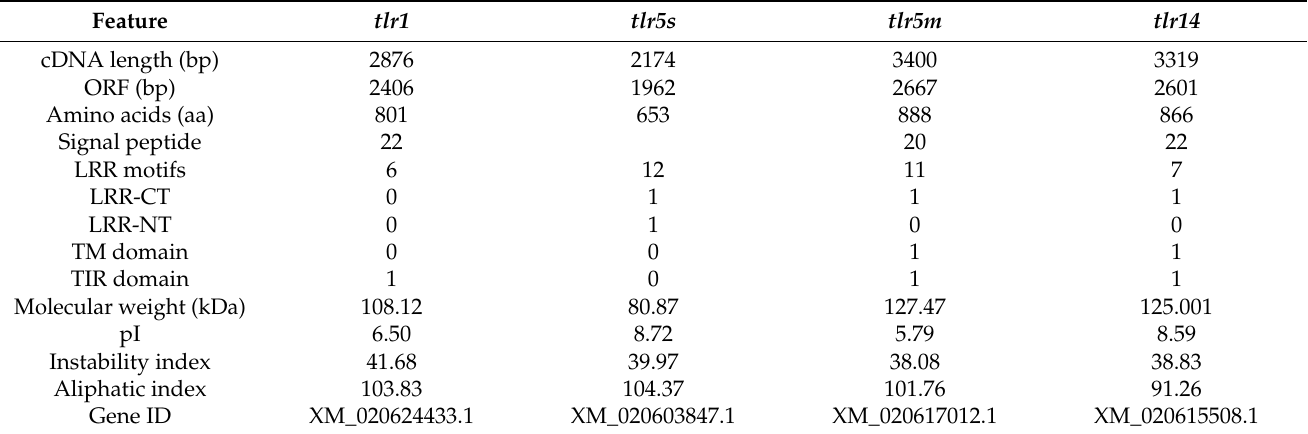
Table 2. The sequence information and physiochemical features of TLRs.